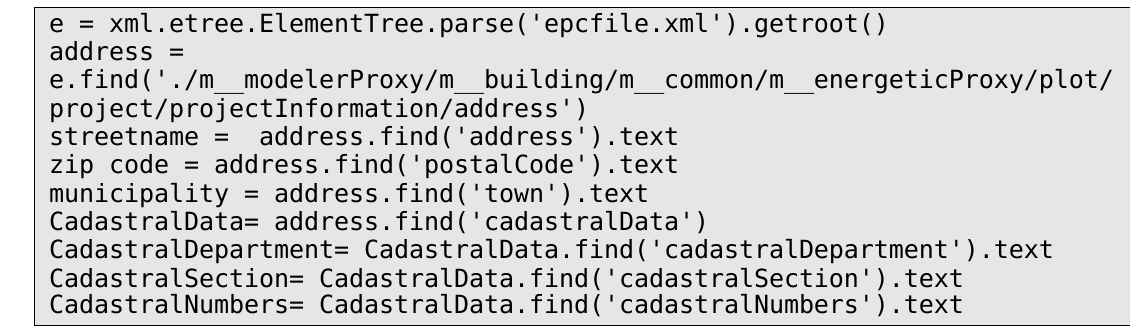
Figure 3. Code segment of the Energy Performance Certificates (EPC) extraction script. Figure 4. Code segment of the Energy Performance Certificates (EPC) extraction